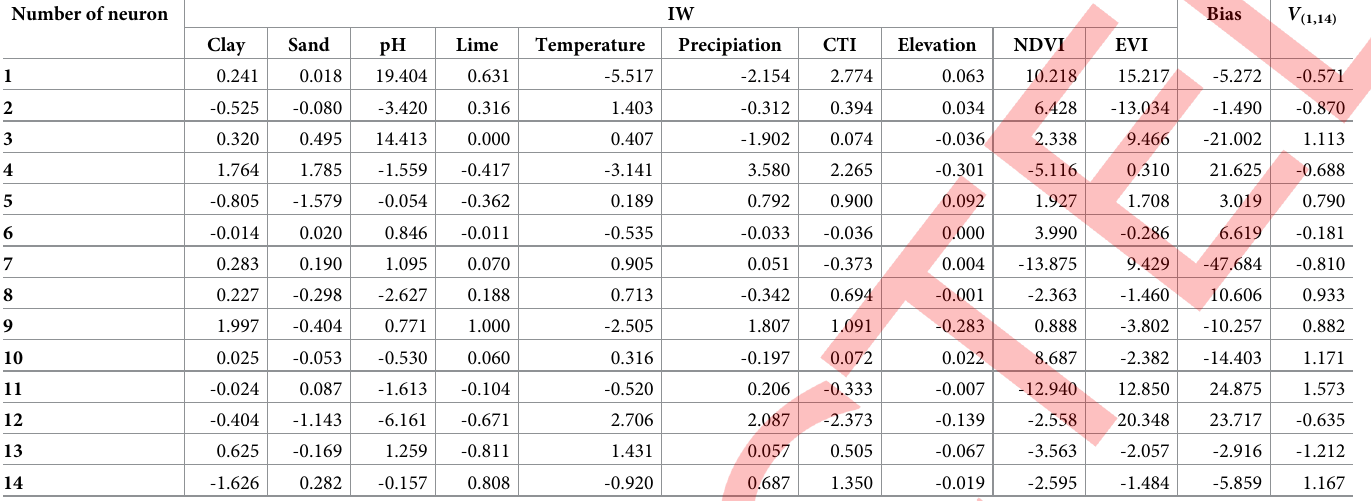
Table 2. Weight and bias values between the input layer and the hidden layer, and the hidden layer and the output layer. Number of